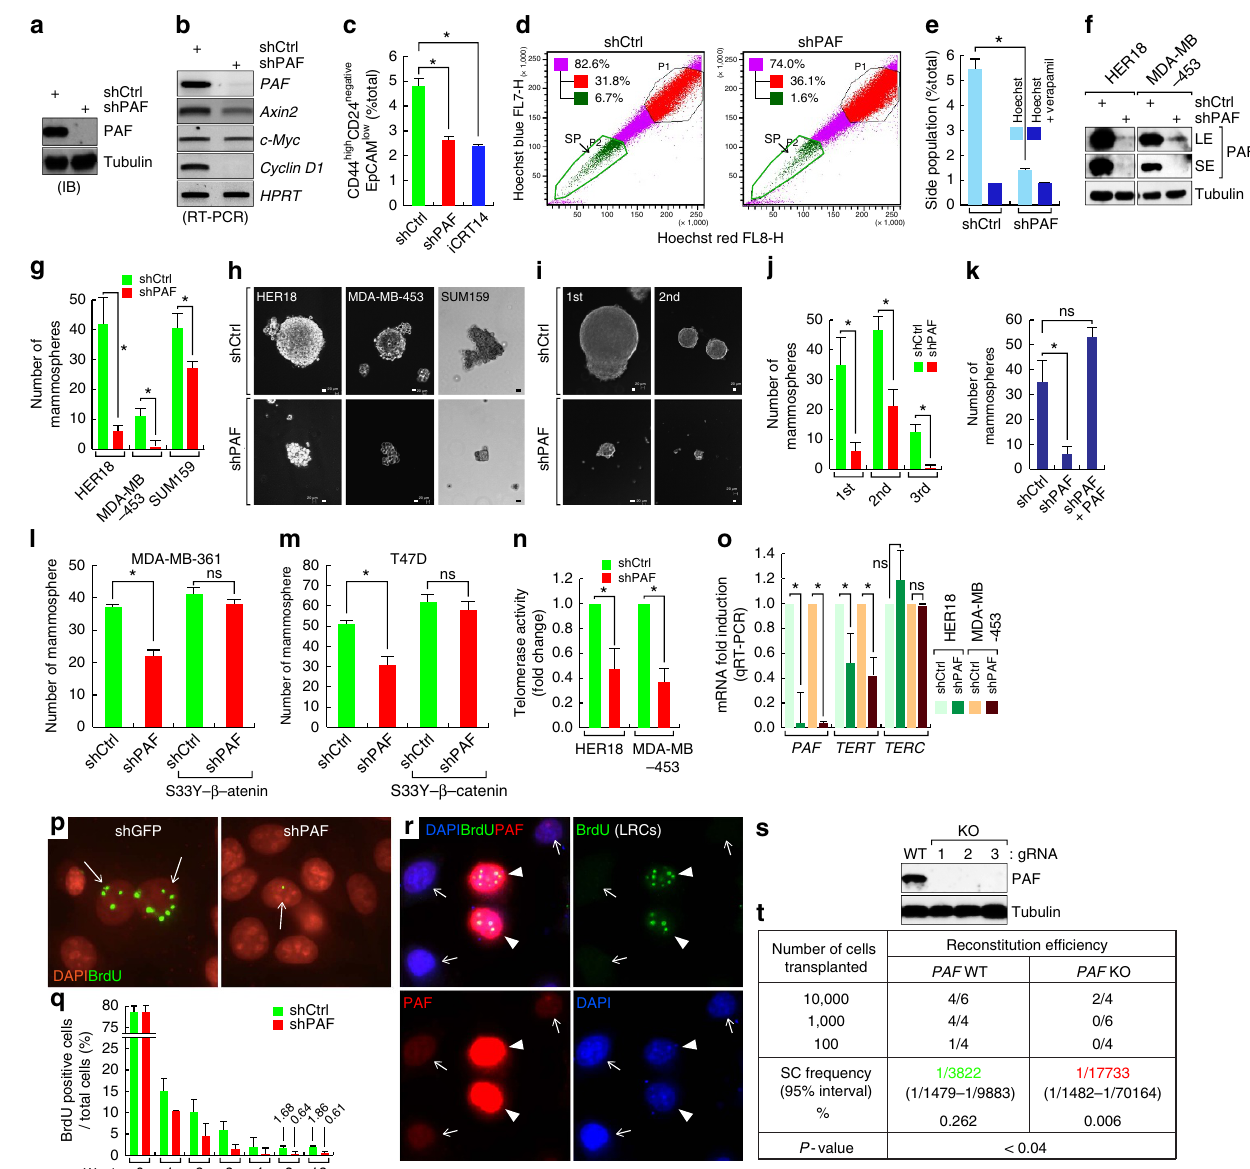
Figure 6 | PAF is required for breast CSC maintenance. ( a , b ) Depletion of endogenous PAF by shPAF. HER18 human breast cancer cells were transduced with lentivirus encoding shCtrl (control) or shPAF (PAF depletion) and selected with puromycin. PAF knockdown was confirmed using IB ( a ) and semi- quantitative reverse transcriptase–PCR (RT–PCR) ( b ). Tubulin and HPRT served as internal controls. ( c – e ) PAF depletion decreases breast CSC population. HER18 cells (shCtrl (control), shPAF or iCRT14 treated) were analysed by flow cytometry and CSL population (CD44 high CD24 negative EpCAM low ) was quantified ( c ). Side population analysis ( d ). Verapamil-treated samples served as negative controls ( e ). Student’s t -test; error bars ¼ s.e.m. ( f ) Depletion of endogenous PAF by short hairpin RNAs (shRNAs) in breast cancer cell lines. IB analysis. ( g – j ) Decrease in mammosphere formation by PAF depletion. Quantification of the number of mammospheres ( g ) and phase-contrast images ( h ). Sequential mammosphere formation of HER18 cells ( i , j ). Of note, SUM159 and MDA-MB-453 cells did not form clear mammospheres. Student’s t -test; error bars ¼ s.e.m. Scale bars, 20 m m. ( k ) Ectopic expression of PAF rescues inhibition of mammosphere formation by PAF depletion. HER18 cells were stably transduced by PAF and analysed for mammosphere formation. Student’s t -test; error bars ¼ s.e.m. ( l , m ) b -Catenin rescues PAF depletion-induced inhibition of mammosphere formation. shCtrl- and shPAF-transduced breast cancer cell lines were stably transfected with S33Y- b -catenin and assessed for mammosphere formation. Student’s t -test; error bars ¼ s.e.m. ( n ) Decreased telomerase activity by PAF depletion. Cells (shCtrl versus shPAF) were analysed for telomerase activity using TRAPEZE RT kits. Student’s t - test; error bars ¼ s.e.m. ( o ) Downregulation of TERT by PAF depletion. Student’s t -test; error bars, s.e.m. Quantitative reverse transcriptase–PCR (RT–PCR) analysis. Of note, TERC was not changed by PAF depletion. ( p , q ) Decrease in LRCs in PAF-depleted HER18 cells. HER18 cells were labelled with 5-bromodeoxyuridine (BrdU) for 24h and analysed for LRCs by counting BrdU-positive cells ( n , microscopic images; o , graph). Of note, initially, equal number of cells (shCtrl versus shPAF) displayed BrdU incorporation. Student’s t -test; error bars ¼ s.e.m. ( r ) High expression of PAF in LRCs. HER18 LRCs (2 months) were analysed for IF staining. Arrowheads: PAF high and BrdU positive cells; arrows: PAF low and BrdU negative cells. ( s ) Somatic KO of PAF by CRISPR. Wesrern blot (WB) analysis of MDA-MB-231 cells. ( t ) PAF KO inhibits stemness of breast cancer cells. MDA-MB-231 ( PAF WTand KO) cells were transplanted into the cleared fat pad of immunocompromised mice. Twelve weeks after transplantation, tumour formation was assessed by extreme limiting dilution analysis. * P o 0.05; NS, not significant ( P Z 0.05); N 4